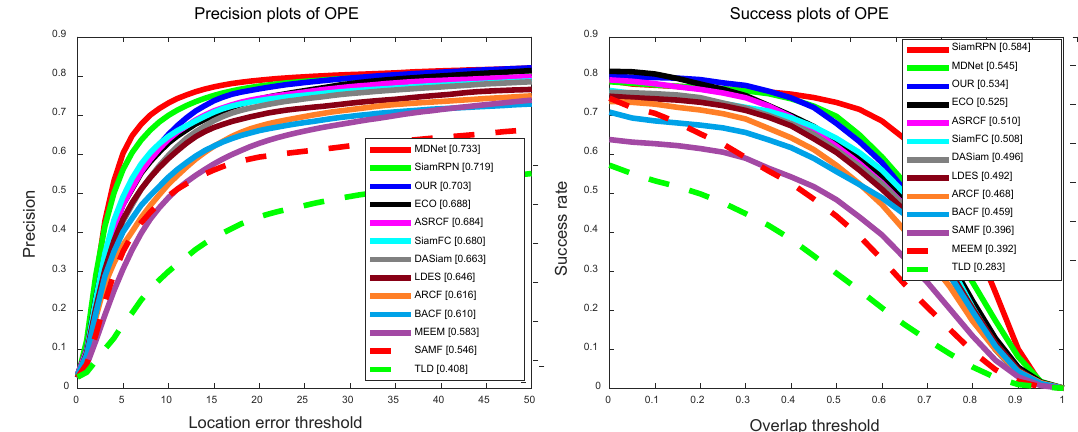
Figure 12. Distance precision and overlap success plots on the UAV123 [6] dataset. The legend of distance precision contains threshold scores at 20 pixels, while the legend of overlap success contains area-under-the-curve scores for each tracker. The proposed algorithm performs favorably against state-of-the-art trackers.